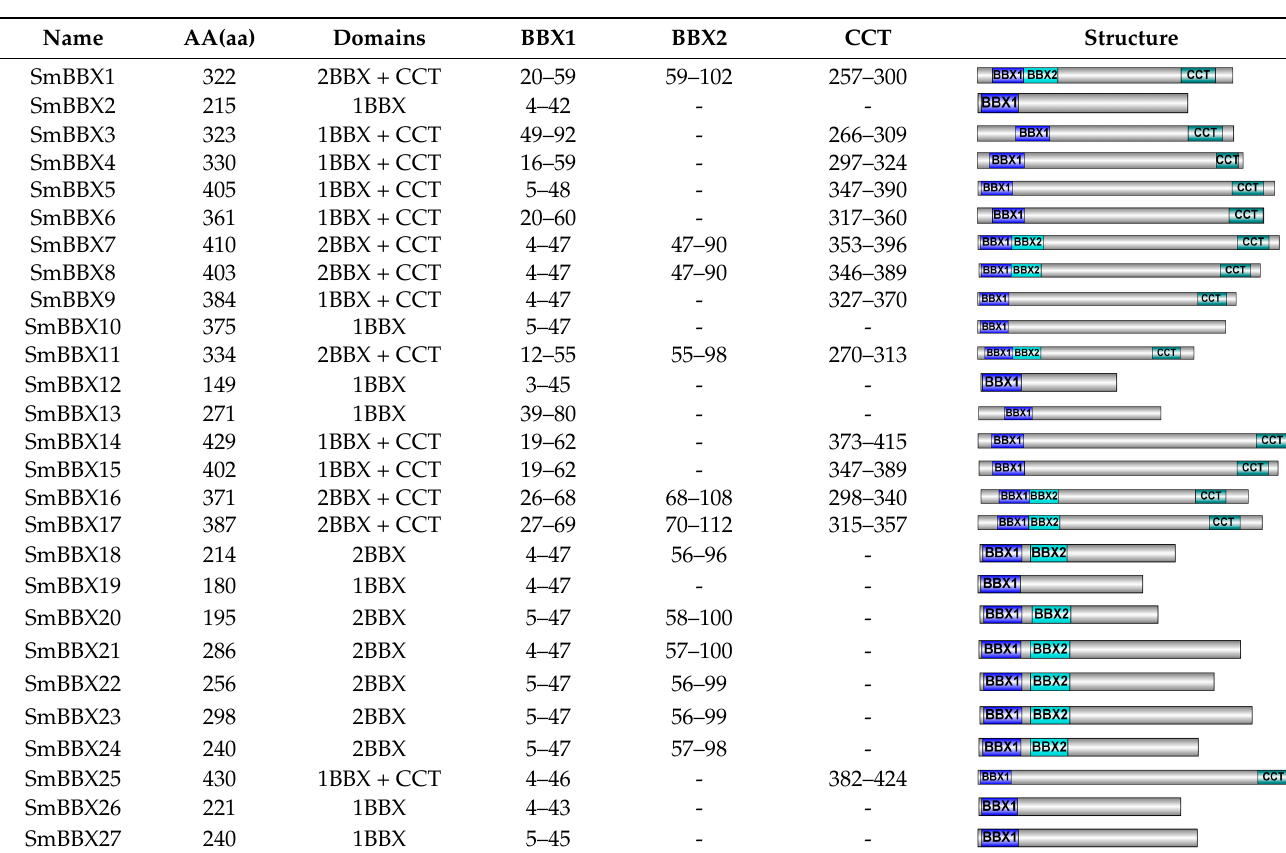
Table 2. SmBBXs protein structures.